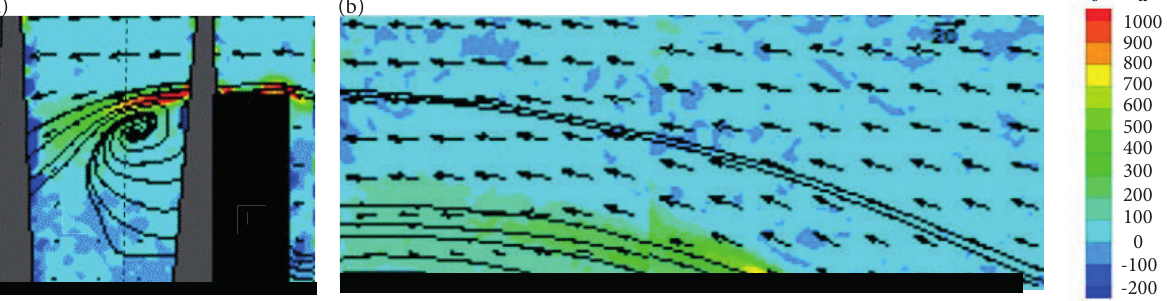
Figure 13. Vorticity contours and velocity vectors – β = 90°, α = 35° and Re = 4.3 × 10 5